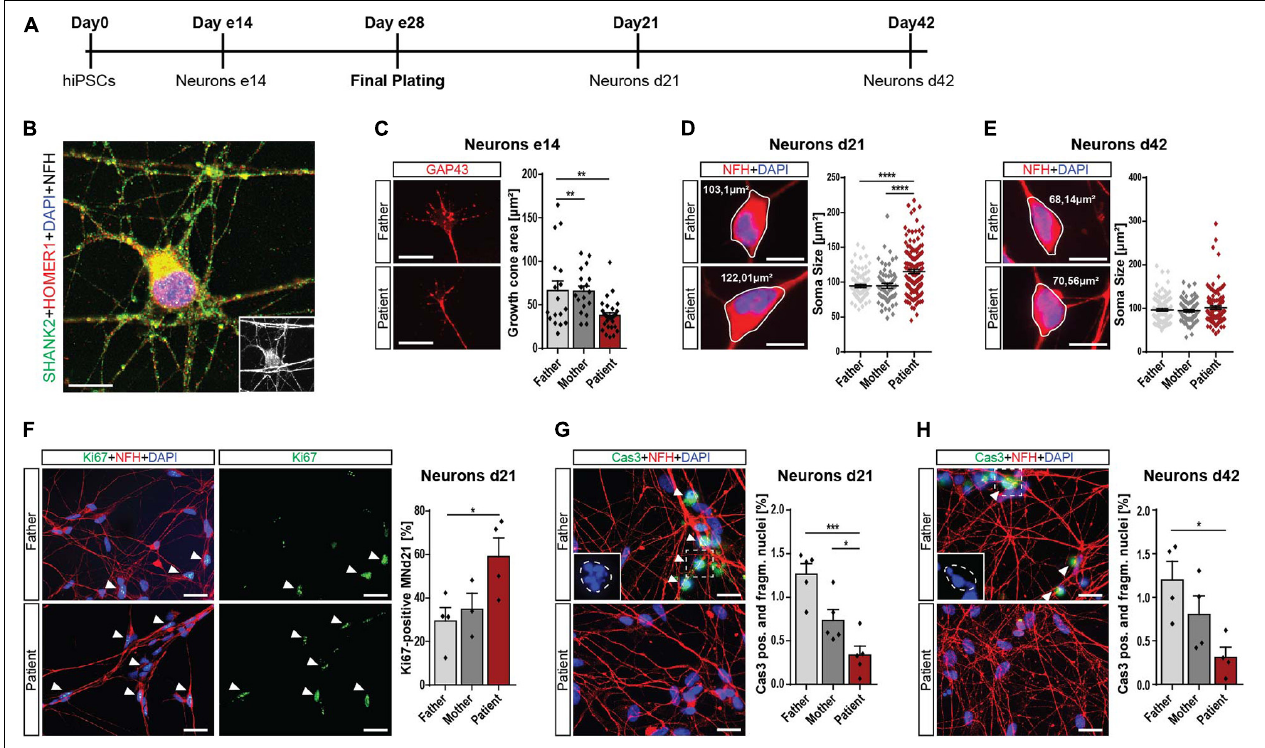
FIGURE 2 | Neurodevelopmental changes in SHANK2 deletion neurons. (A) The differentiation scheme of hiPSC-derived neurons. (B) A 42-day-old neuron stained against SHANK2, HOMER1, and NFH shows a mature morphology and synaptic co-localization. Inlay: NFH. Scale bar = 10 µ m. (C) Staining for GAP43 in e14 neurons. The growth cone area was quantified. Data collected form three independent experiments. Scale bar = 20 µ m. (D,E) Staining for NFH. Soma size [ µ m 2 ] of NFH-positive neurons was measured in neurons d21 (D) and d42 (E) Scale bar = 10 µ m. (F) Staining of neurons d21 for Ki67 and NFH. Percentage of Ki67-positive neurons was quantified. Data collected from four independent experiments. Scale bar = 10 µ m. (G,H) Staining for cleaved caspase 3 and NFH. Neurons positive for cleaved caspase 3, and manifesting fragmented nuclei were assessed. n = 5 for d21 (G) and n = 4 for d42 (H) . Inlay shows fragmented nuclei. The estimated shape of the original non-fragmented nucleus is illustrated. Scale bar = 20 µ m. NFH, neurofilament heavy chain. Data were normalized to mean of parents if indicated. Mean ± SEM, one-way ANOVA, followed by Tukey’s post hoc analysis. Significance levels were set * p ≤ 0.05, ** p ≤ 0.01, *** p ≤ 0.001, and **** p ≤